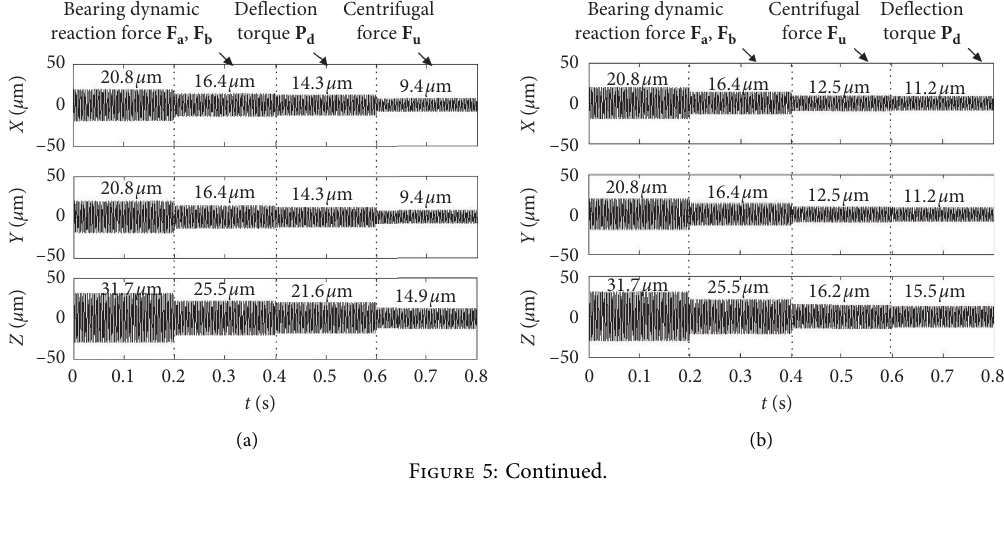
Figure 4: Feedforward suppression against three interferences: (a) bearing reaction dynamic force F (c) centrifugal force F u